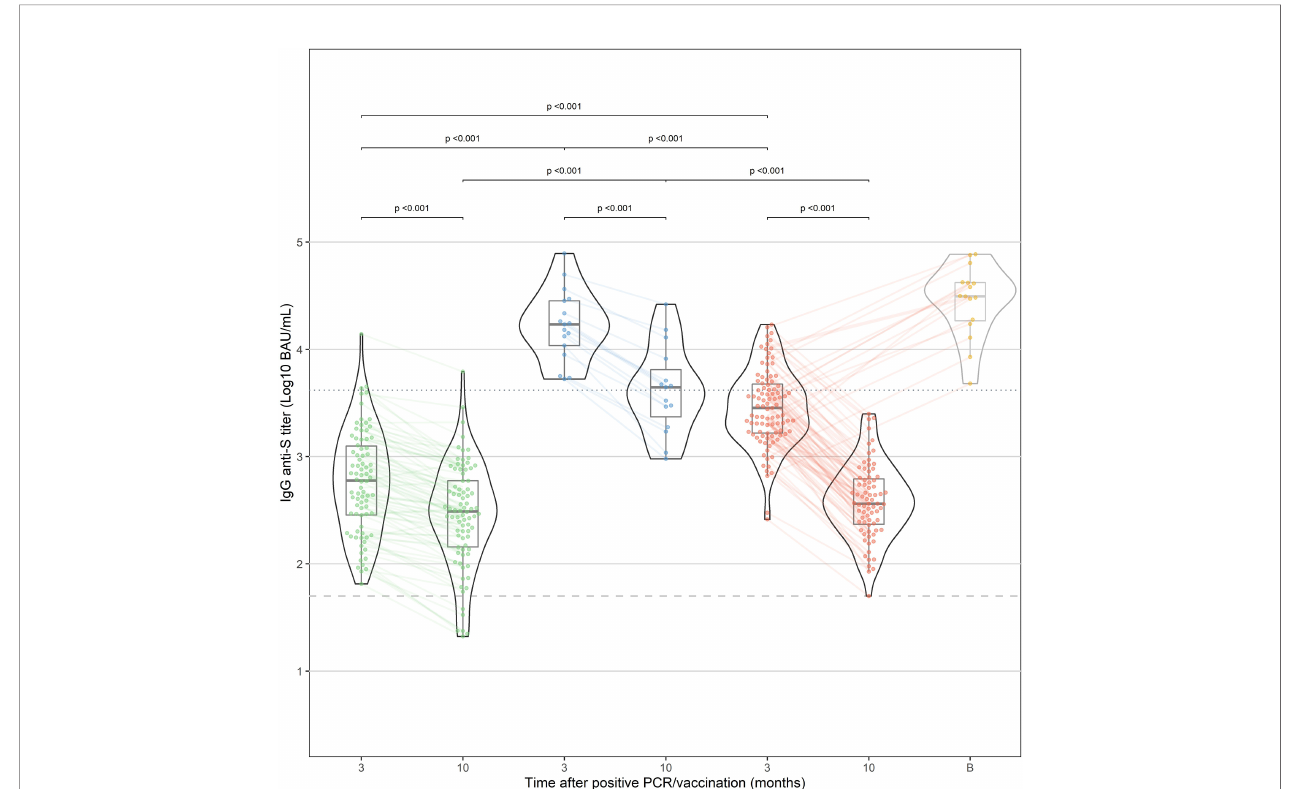
FIGURE 1 | IgG anti-S antibody response after natural infection ( “ infection ” , green) and after vaccination in previously infected HCW ( “ hybrid immunity ” , blue) and naive HCW ( “ vaccination ” , red). In addition, the results at 10 months of HCW who have received a booster dose before the 10-month time point are shown in yellow (excluded for statistical analysis). Median time after booster (shown as time point "B") was 21 days (IQR: 13.8-39.5